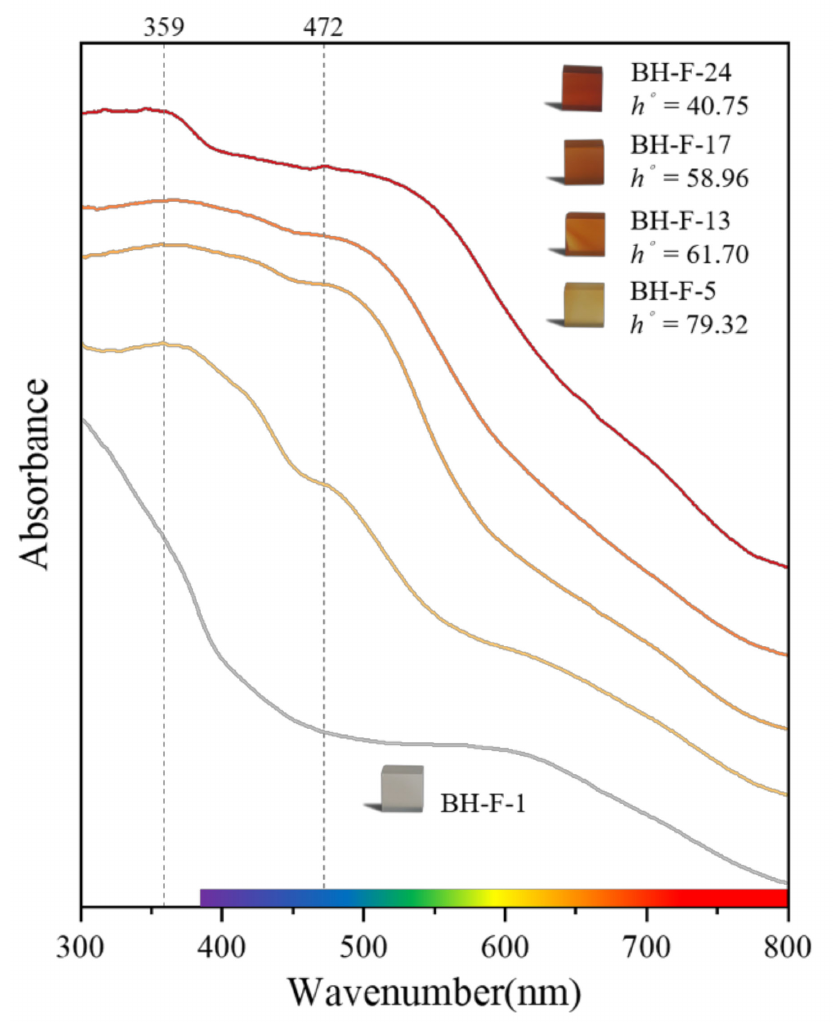
Figure 7. UV-VIS spectra of typical Beihong agate samples. Four typical samples (BH-F-5, -13, -17, -24) were pale yellow to orange-red (hue angle 79.32, 61.70, 58.96, and 40.75, respectively), and BH-F-1 as a nearly colourless control